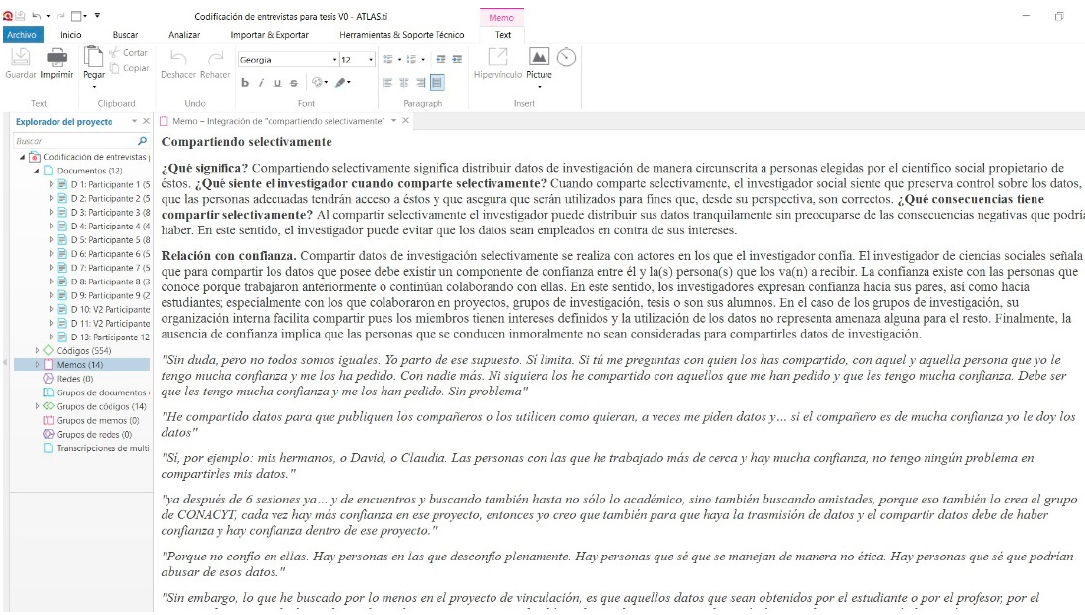
Figure 2. Example of a memo in Atlas.ti 8.